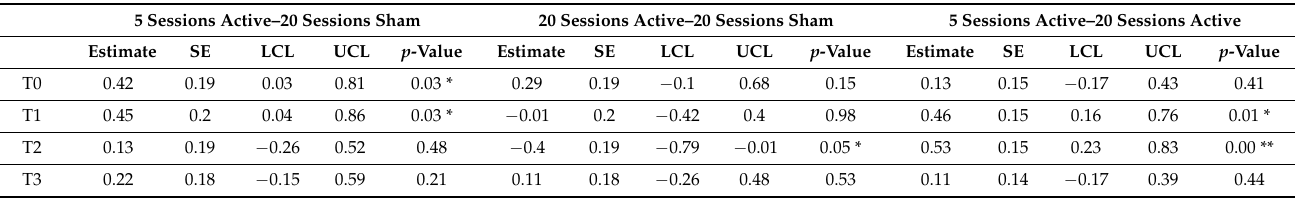
Table 3. Multiple comparison for each treatment group within each time point for the sgACC.